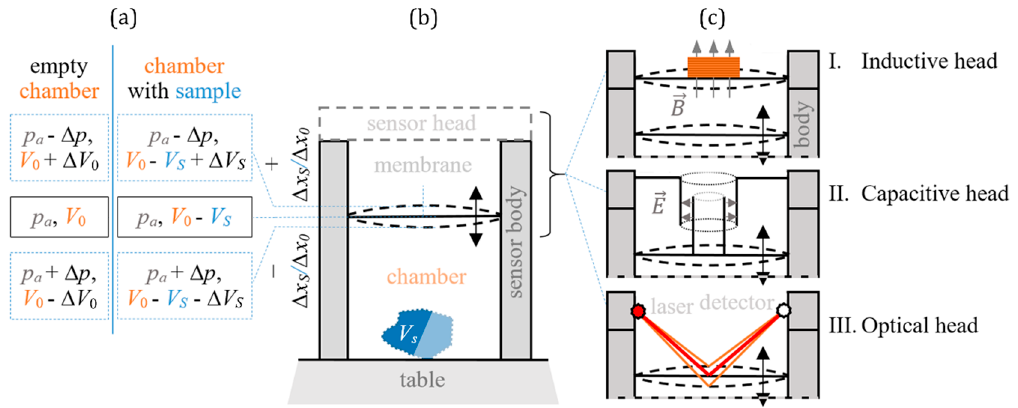
Figure A1. Measurement principles of an acoustic volumeter. ( a ) Values of pressure and volume for a chamber ( b ) when the excitation membrane moves up and down by ∆ x 0 (for an empty chamber) or ∆ x S (for a chamber with a sample) and at its equilibrium position. ( c ) Determination of the membrane position can be realized by three di ff erent modalities (I, II, and III) explained in the text.